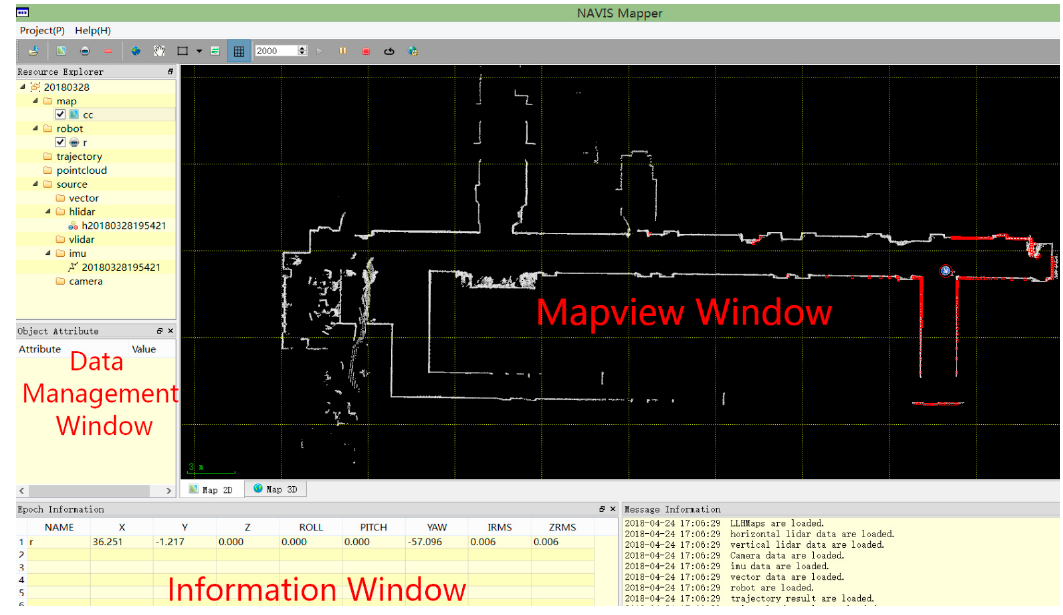
Figure 5. LiDAR SLAM software.